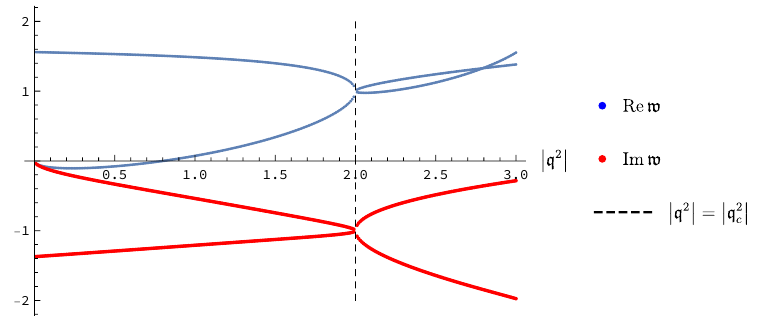
Figure 12 . Quasinormal spectrum level-crossing in the sound channel: the real (blue curves) and the imaginary (red curves) parts of the hydrodynamic sound mode and the closest gapped quasinormal mode dispersion relations plotted as functions of j q 2 j at the (cid:12)xed phase (cid:18) = (cid:25)= 2 of the complex momentum q 2 = j q 2 j e i(cid:18) . At j q 2 j = j q 2 j = 2, the level-crossing occurs. c